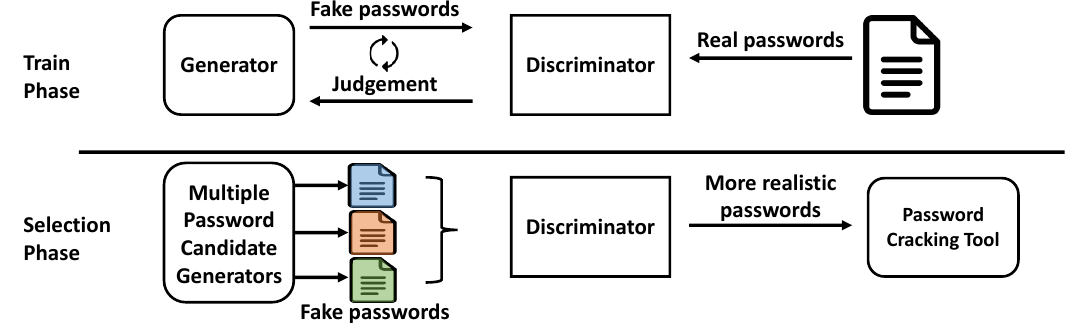
Figure 1. Overview Diagram of